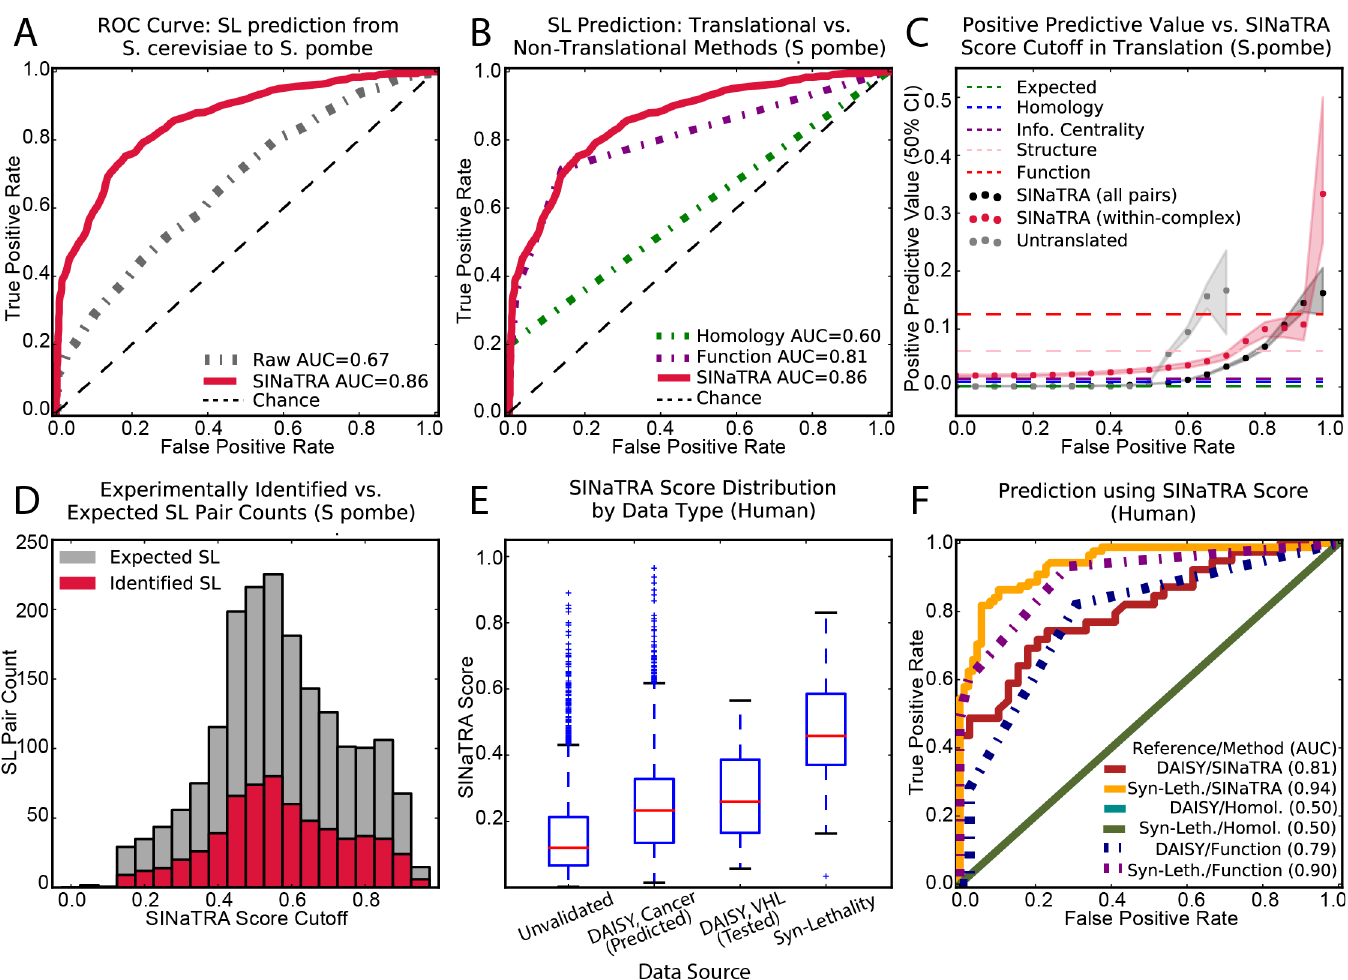
Fig 2. A. Receiver operating characteristic (ROC) curves for classification of SL/non-SL gene in S . pombe using S . cerevisiae as source. Comparison of untranslated ( “ raw ” ) parameters (gray, AUC = 0.67) and the translated parameters used in SINaTRA (red, AUC = 0.86). B. ROC curve of SL predictions using SINaTRA (AUC = 0.86) compared functional homology of gene pair products (AUC = 0.81) and gene homology (AUC = 0.60). The model based on gene homology was created using only gene pairs with homology data. C. Positive predictive value (PPV) of all (dark gray) and within-complex (red) gene pairs. When accounting for the expected ratio of SL:NSL (1:1000), a SINaTRA score threshold of 0.95 yields a median PPV of 17% (a 170-fold increase over what is expected by chance). At 0.85, the PPV drops to 7%. PPV increases in within-complex gene pairs, suggesting that this may be a good initial filter for experimental validation. D. At each SINaTRA score cutoff, we plot the number of experimentally identified SL pairs in that bin (red), as well as the number we expect to find at each level (gray). E. SINaTRA scores of all human predictions, as well as pairs predicted or found to be SL in two datasets: DAISY and Syn-Lethality. F. We compare the predictive ability of SINaTRA score to identify genes belonging to DAISY (tested) and Syn-Lethality datasets compared to functional similarity and homology.